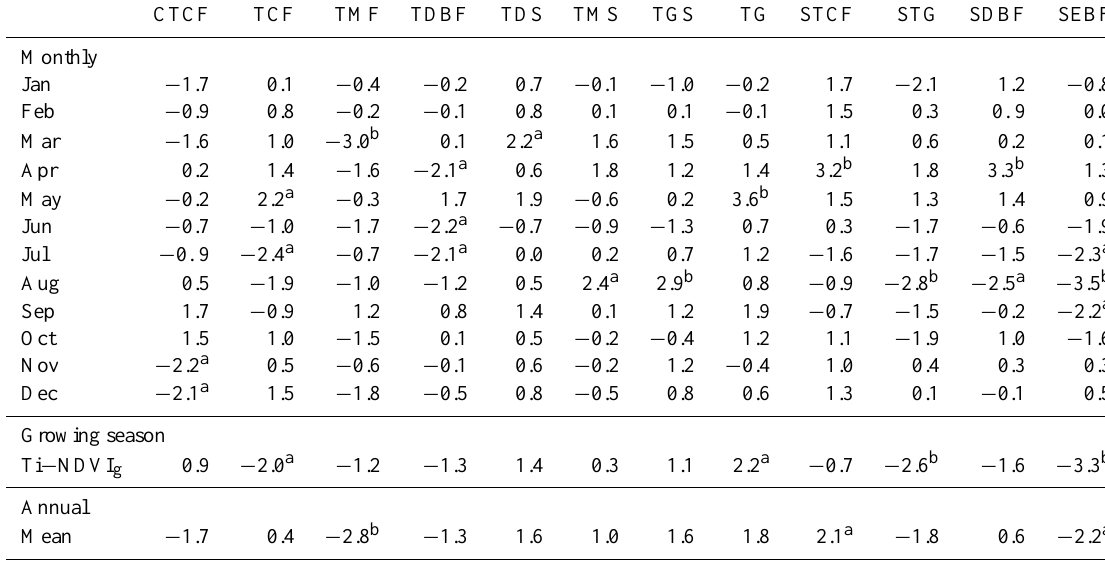
Table 4. Seasonal Mann–Kendall (SMK) trend tests of NDVI by vegetation type from 1982 to